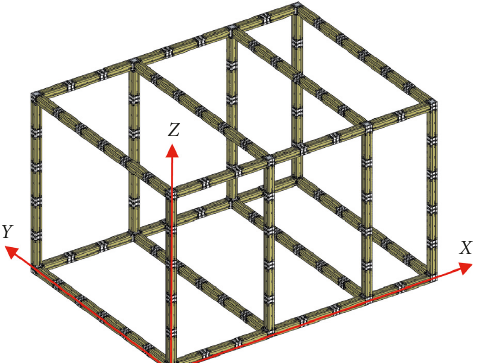
Figure 16: Volume generated by wall frames in 2 planes parallel to XZ plus beam frames in 4 planes parallel to YZ .